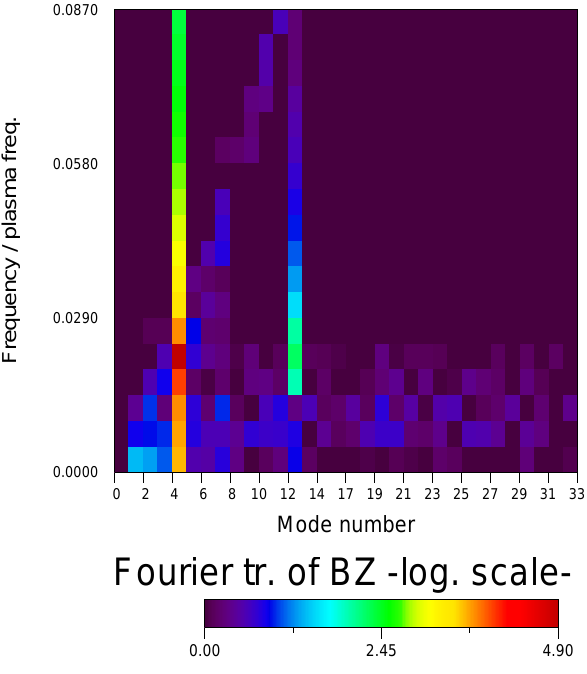
Fig. 6. AWC010 (two sinusoids). Space-time Fourier transform of B Z (X,t) . The horizontal axis displays the spatial mode number, and the vertical axis represents the frequency. The colour scale shows the logarithm of the mode